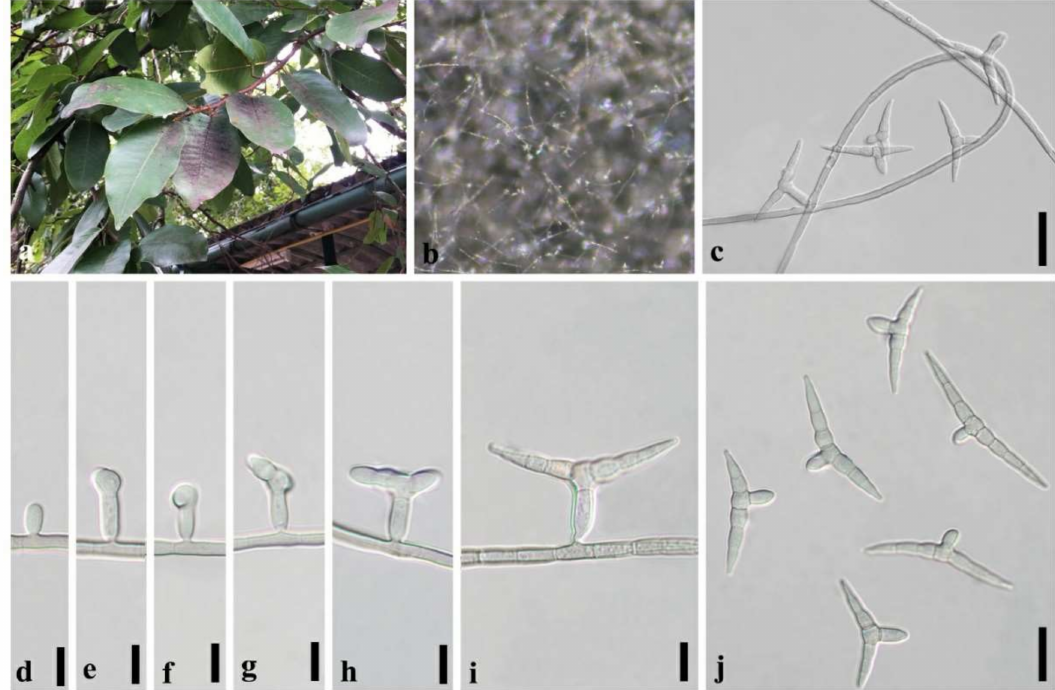
Figure 5. Trichomerium deniqulatum ( a ) sooty mold on Shorea roxburghii , ( b ) colony with conidia on PDA, ( c ) conidia and conidiophore, ( d – i ) immature conidia at various stages of development attached to the prostrate mycelium, ( j ) conidia. Scale bars: ( d – i ) = 10 µ m; ( c , j ) = 20 µ